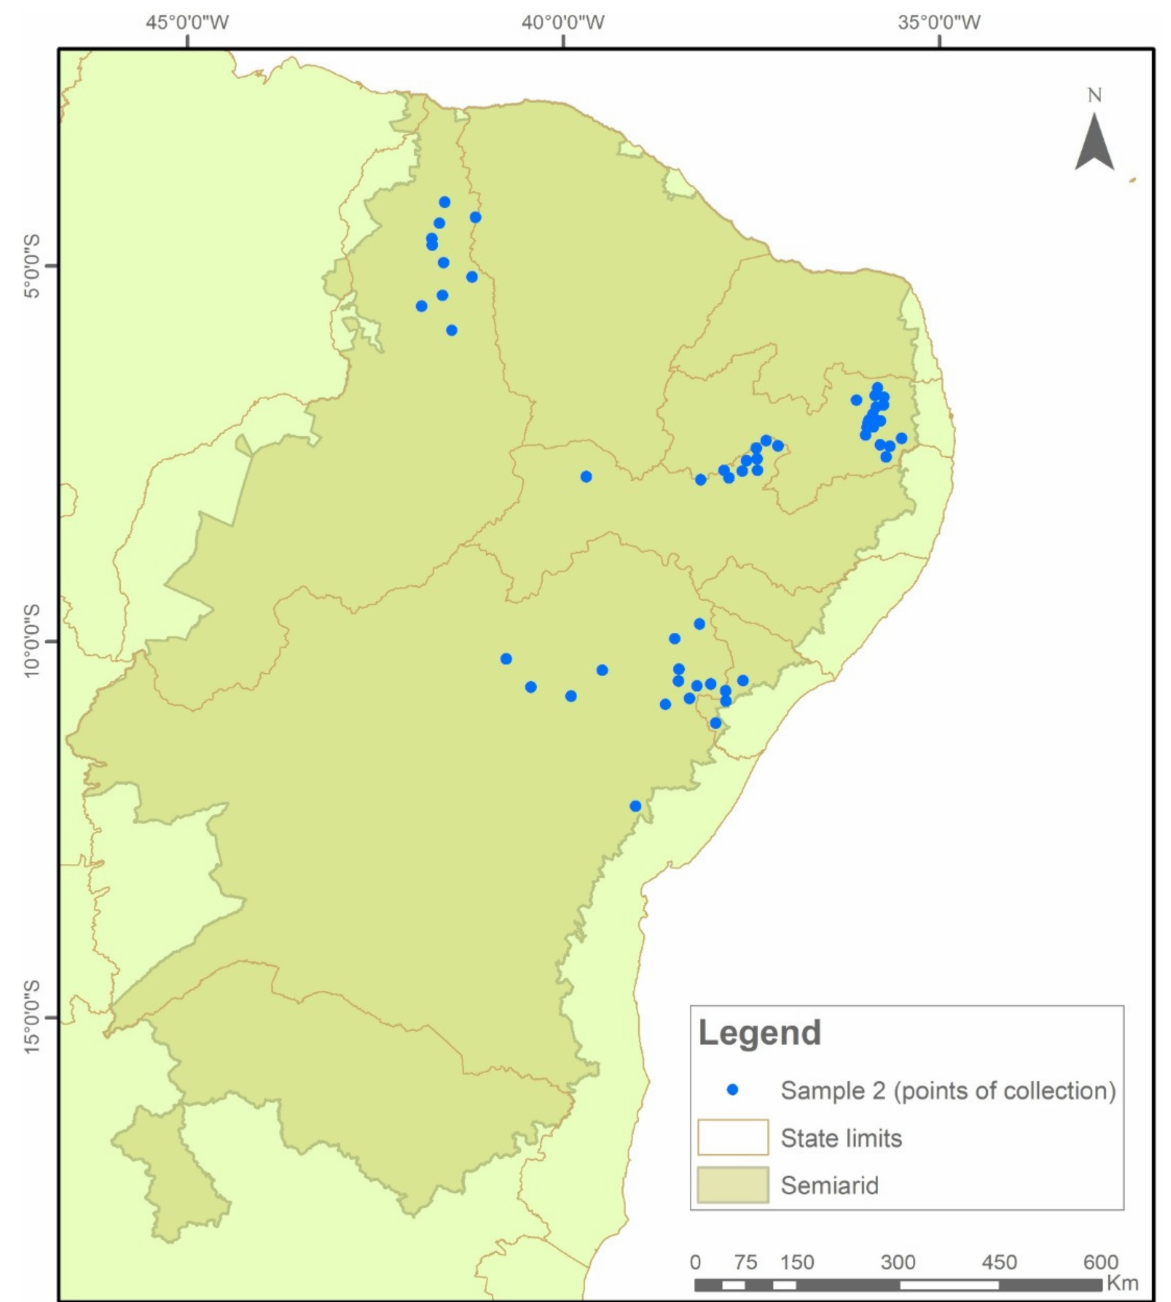
Figure 8. Indication of seed sample collection points in municipalities in the Brazilian Semi-arid Region,